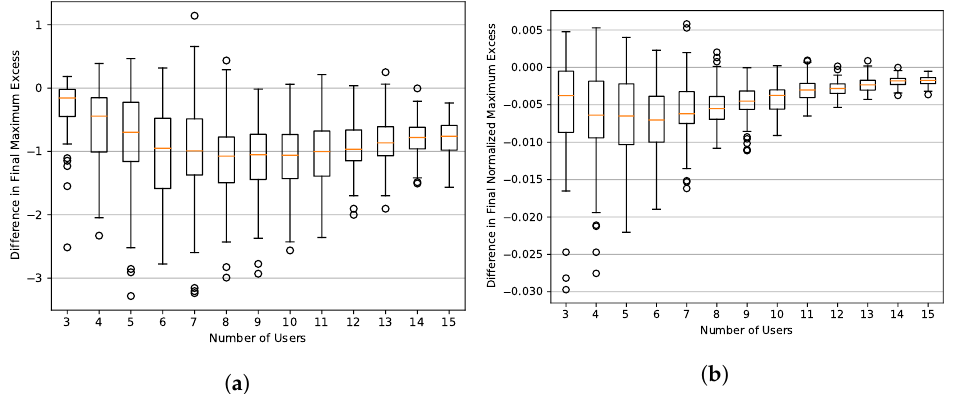
Figure 13. Boxplot of difference between final maximum excess ( a ) and normalized excess ( b ) of day-wise and full-period Shapley–core in 1000 trials separated by the number of users in the